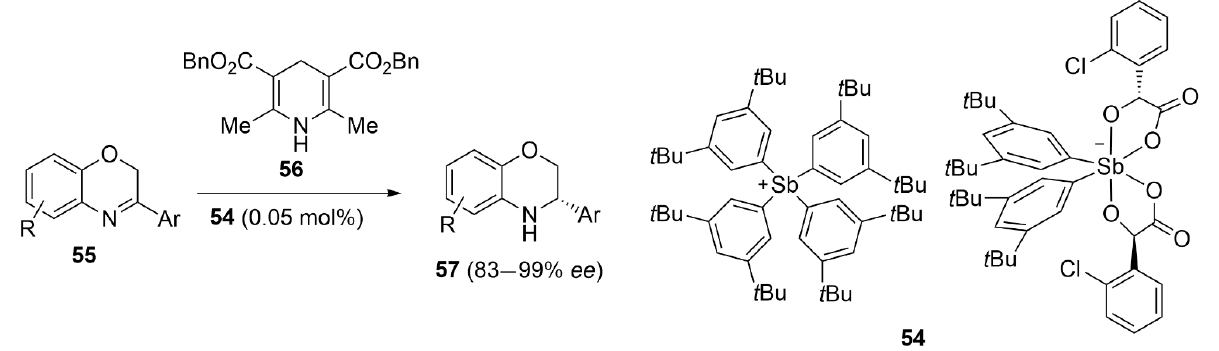
Figure 23. PnB-catalyzed asymmetric reduction in benzoxazines 55 .